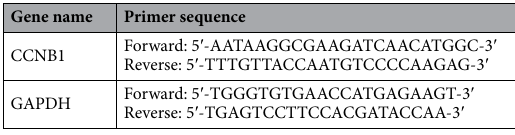
Table 4. Primers used for real-time PCR